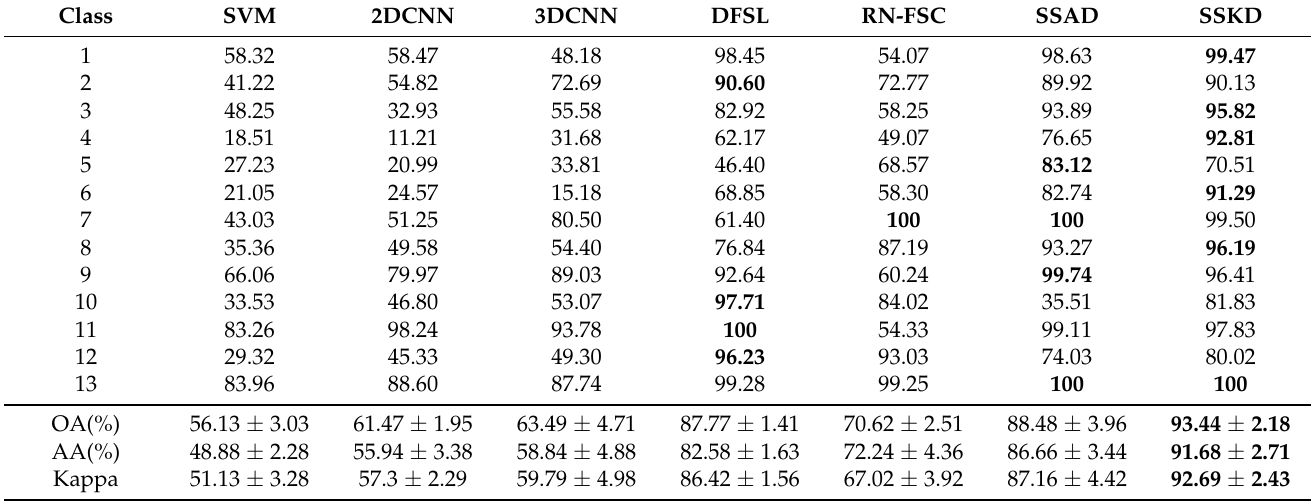
Table 7. The classification accuracy of several different methods on the KSC dataset, with five labeled samples for each category. The best accuracy is shown in bold.